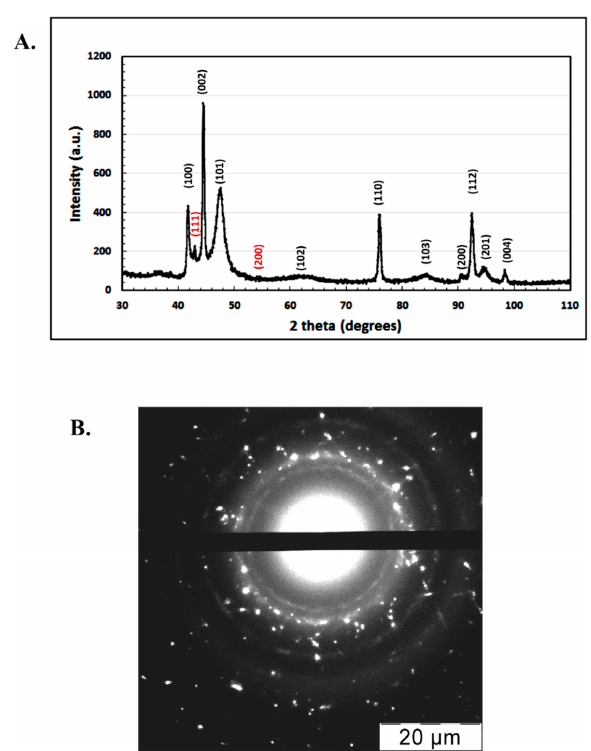
Figure 1. ( A ) X-ray diffraction (Cu K α ), and ( B ) selected area electron diffraction (SAED) results on synthesized Co nanopowders.